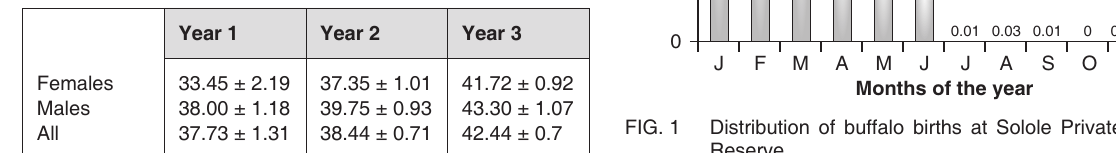
TABLE 2 Variation in buffalo calf masses (kg mean ± s.e.) ac- cording to